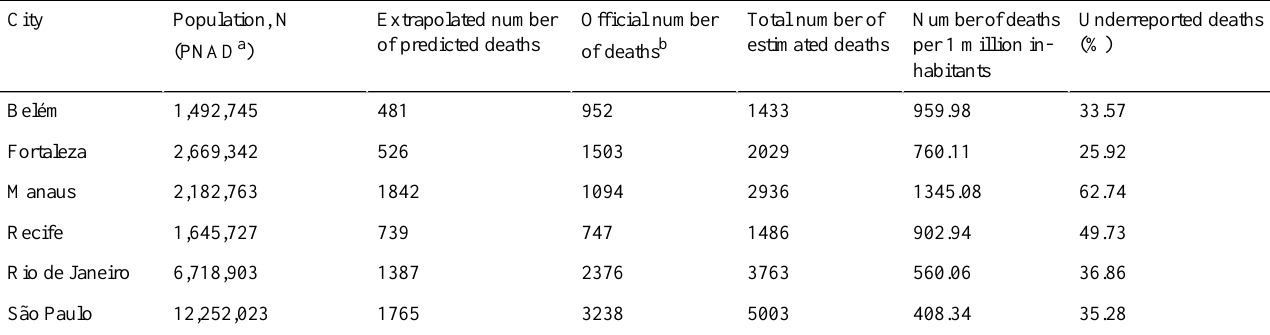
Table 6. Underreported deaths due to coronavirus disease